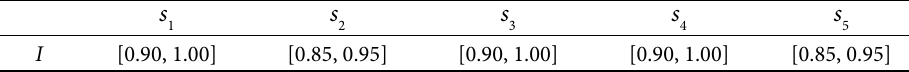
Table 8. Ideal artillery weapon